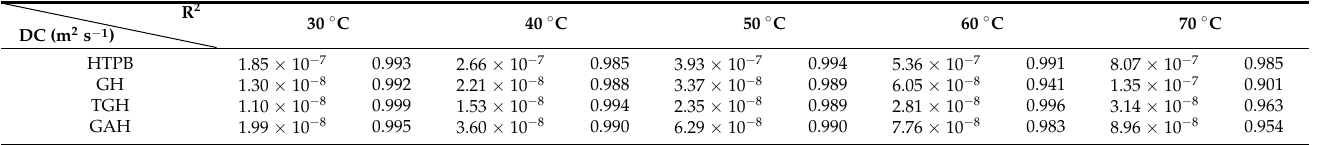
Table 2. DOS migration coefficients (m 2 s − 1 ) and linear correlation coefficients in different liners.